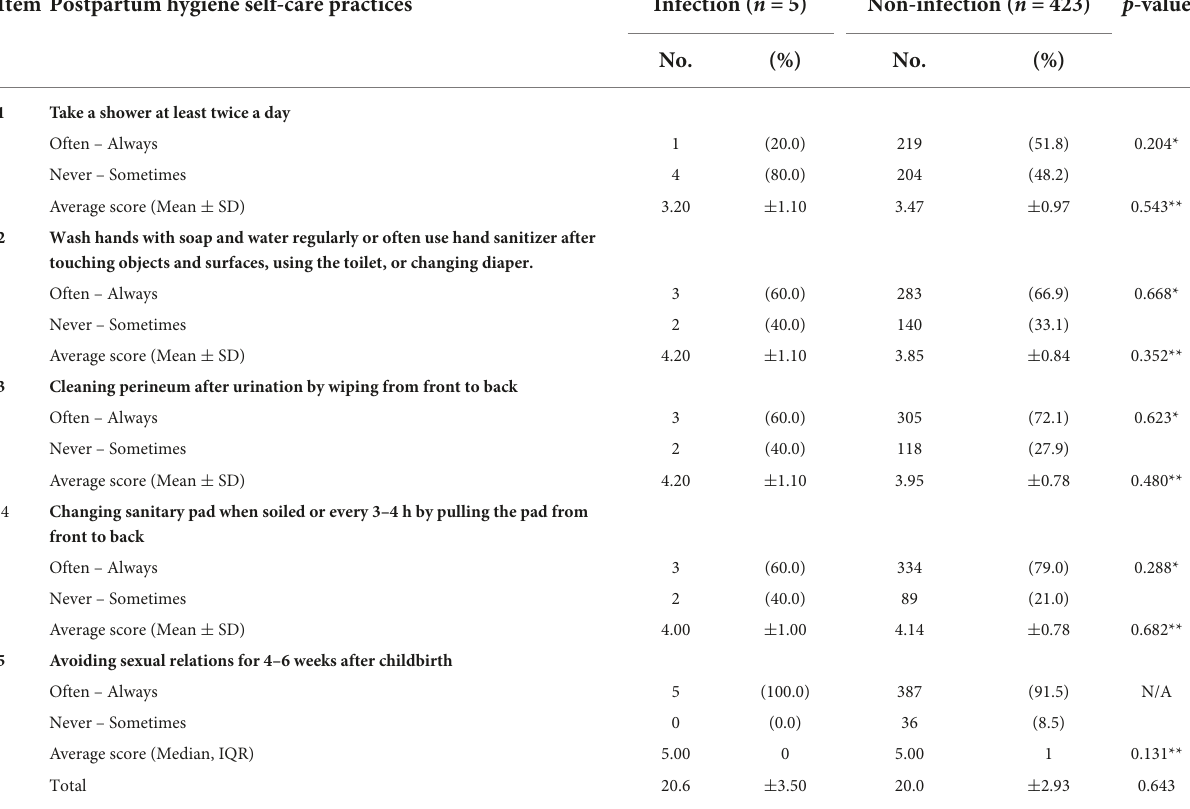
TABLE 4 Postpartum hygiene self-care practices in infected and non-infected groups. Item Postpartum hygiene self-care